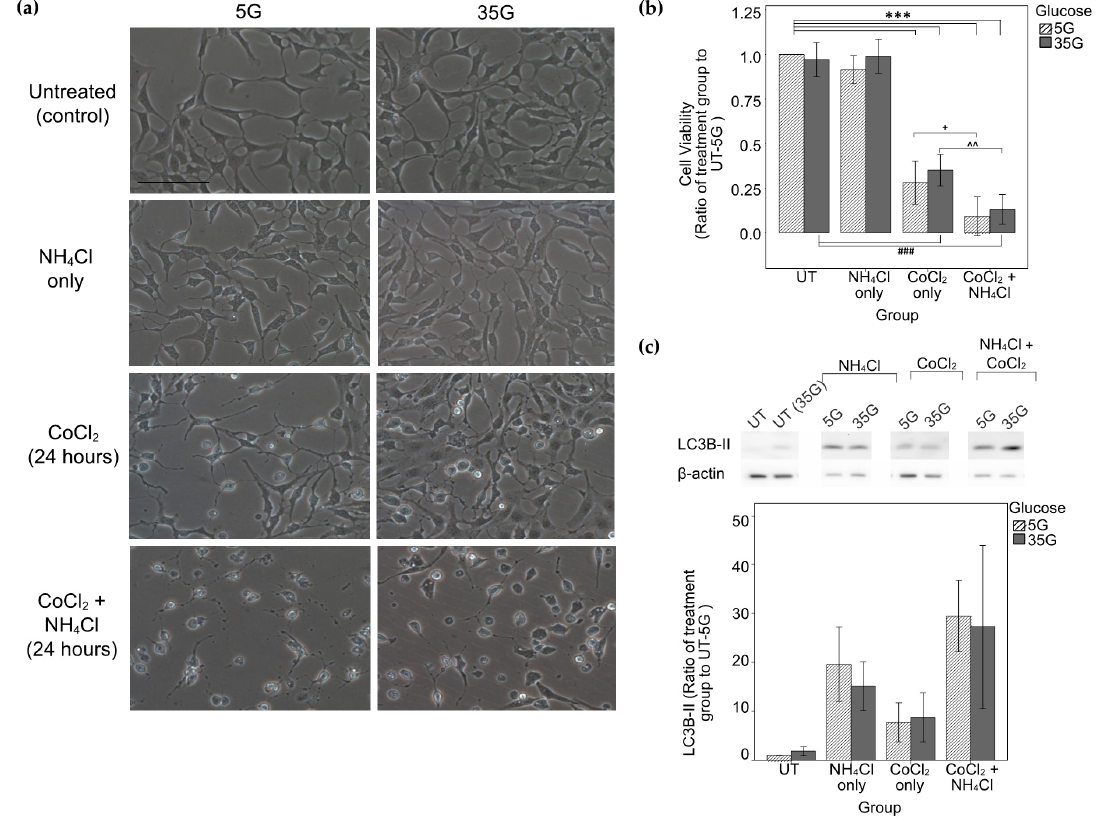
Figure 6. Cell morphology, cell viability and western blot analysis of LC3B-II in R28 cells after glucose treatment, NH 4 Cl treatment, 250 µ M CoCl 2 chemically-induced hypoxia or chemically-induced hypoxia with NH 4 Cl. ( a ) Cell morphology of cells subjected to CoCl 2 -induced hypoxia and autophagy inhibition. More cytoplasmic vacuoles were observed in cells treated with the autophagy inhibitor in addition to the hypoxic insult, as compared with cells treated with hypoxia only. Scale bars = 100 µ m; ( b ) Cell viability of R28 cells under different treatment conditions. Both low glucose and high glucose-treated cells had significantly lower cell viability when induced with hypoxia as compared to their respective untreated groups. Those treated only with autophagy inhibitors had similar viability to their respective untreated groups. Cells treated with hypoxic insult and autophagy inhibition had lower cell viability than those treated only with hypoxic insult. n = 6. *** p < 0.001 as compared with UT-5G; ### p < 0.001 as compared with UT-35G; + p < 0.05 as compared with CoCl 2 only-5G; ˆˆ p < 0.01 as compared with CoCl 2 only-35G. Values represent mean with error bars +/ − SD; ( c ) Levels of LC3B-II were measured by Western blot analysis and normalized by β -actin. Densitometry analysis showed an increase in LC3B-II levels in cells treated with CoCl 2 as compared with the untreated group. Addition of NH 4 Cl to CoCl 2 in the 5G group further increased the LC3B-II levels as compared with the CoCl 2 only 5G group ( p = 0.051). Figure and caption has been adapted from a dissertation [9]. Please refer to acknowledgements